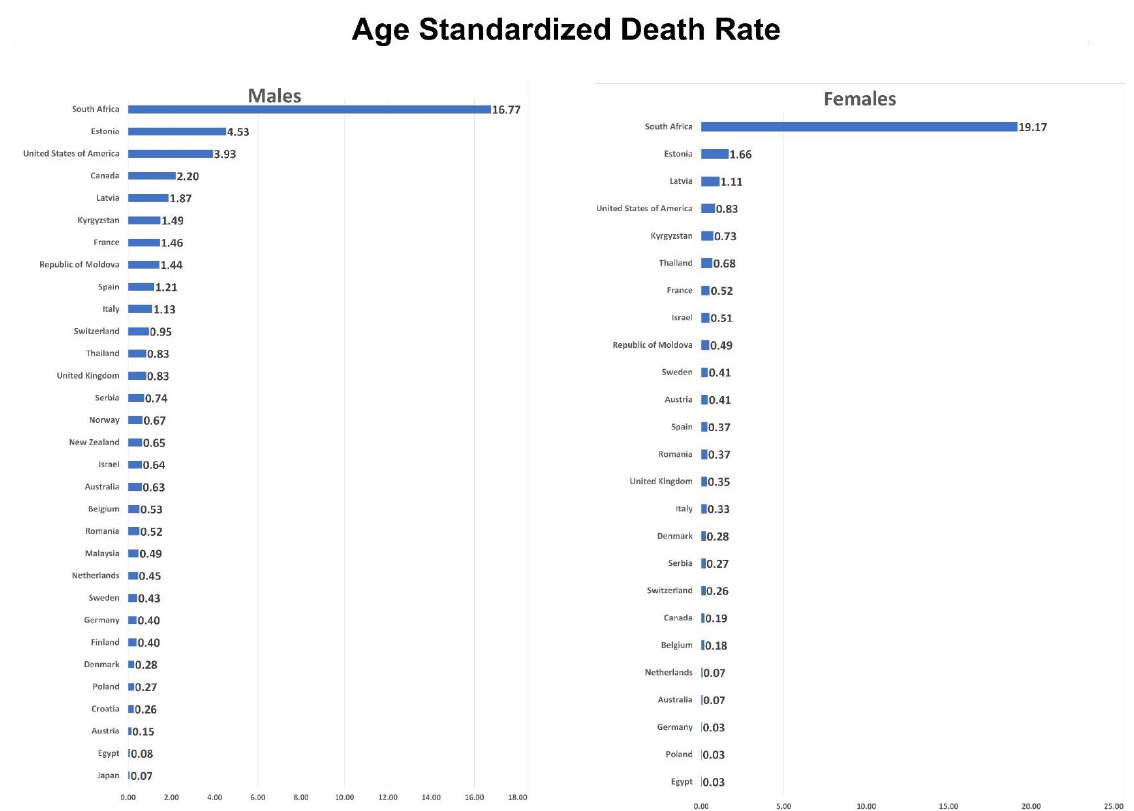
Figure 1. Latest age-standardized death rate in males and females. End point for Canada: 2005, USA: 2007, rest of the countries end point varies between 2013 – 2018.